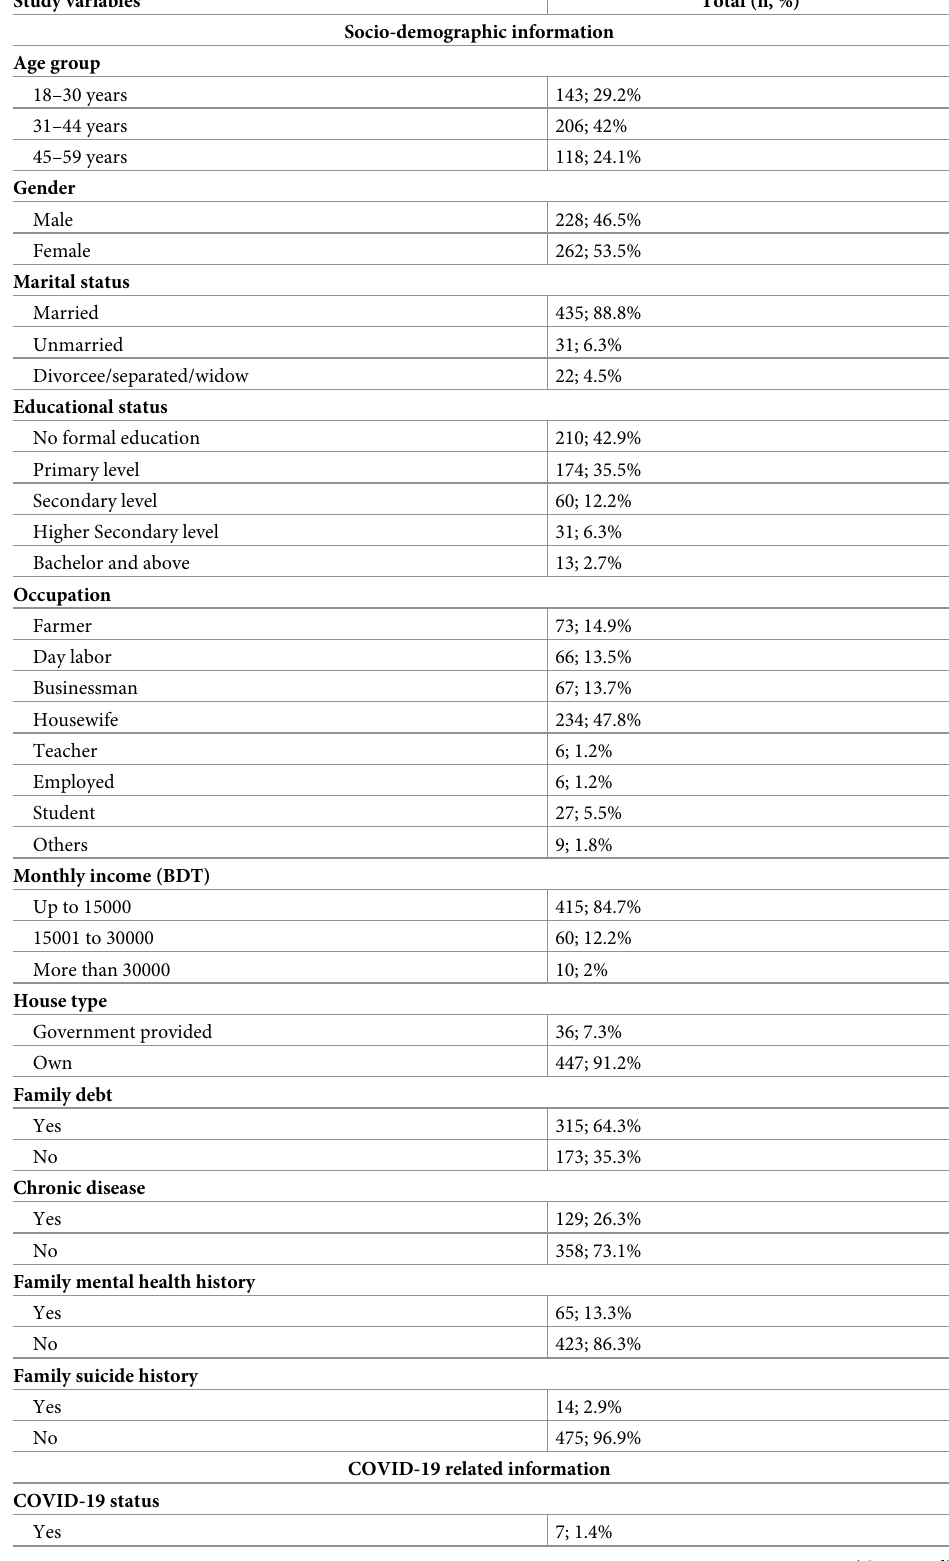
Table 1. Characteristics of the